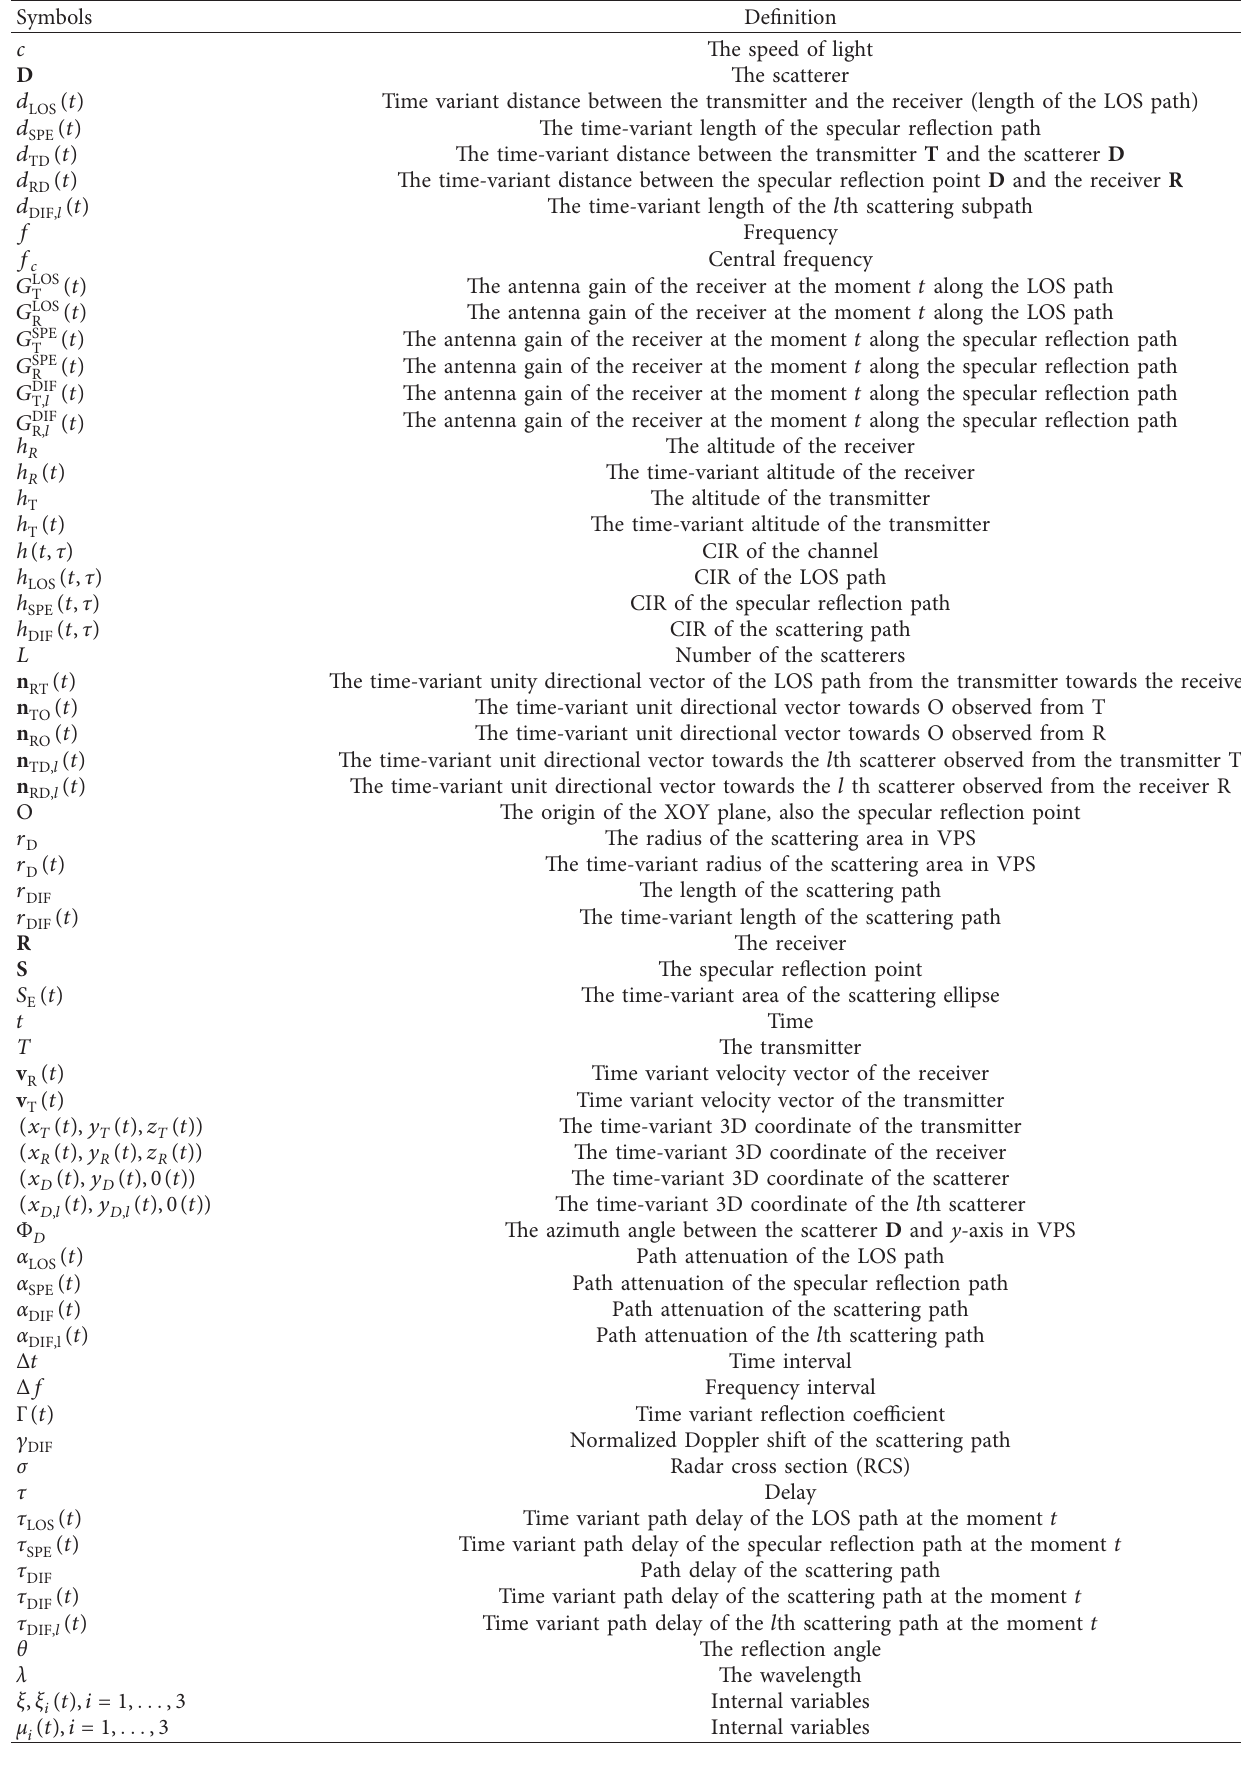
Table 1: Major parameters and symbols this